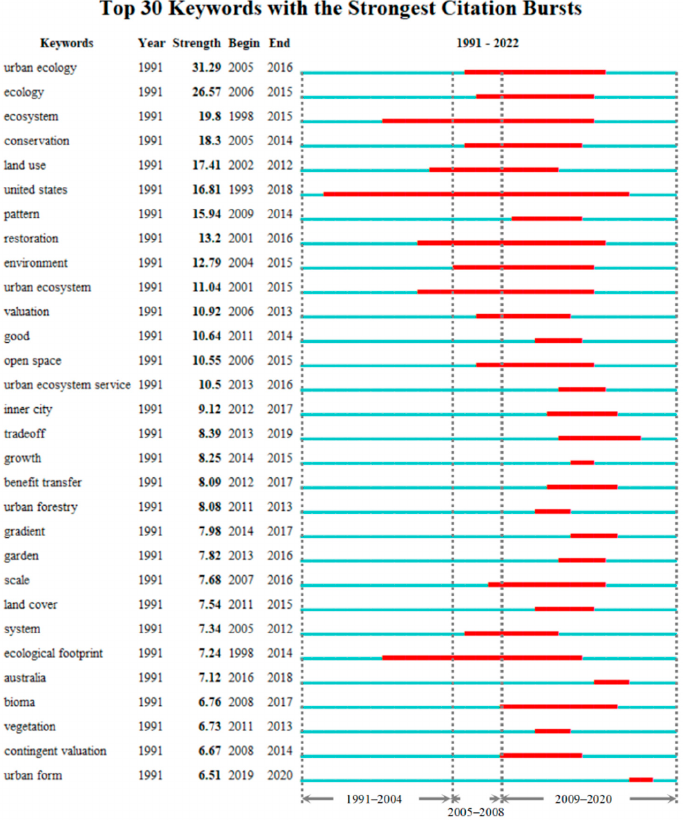
Figure 9. Top 30 keywords with the strongest citation bursts during 1991–2022. Table 8. List of keyword co-occurrence.